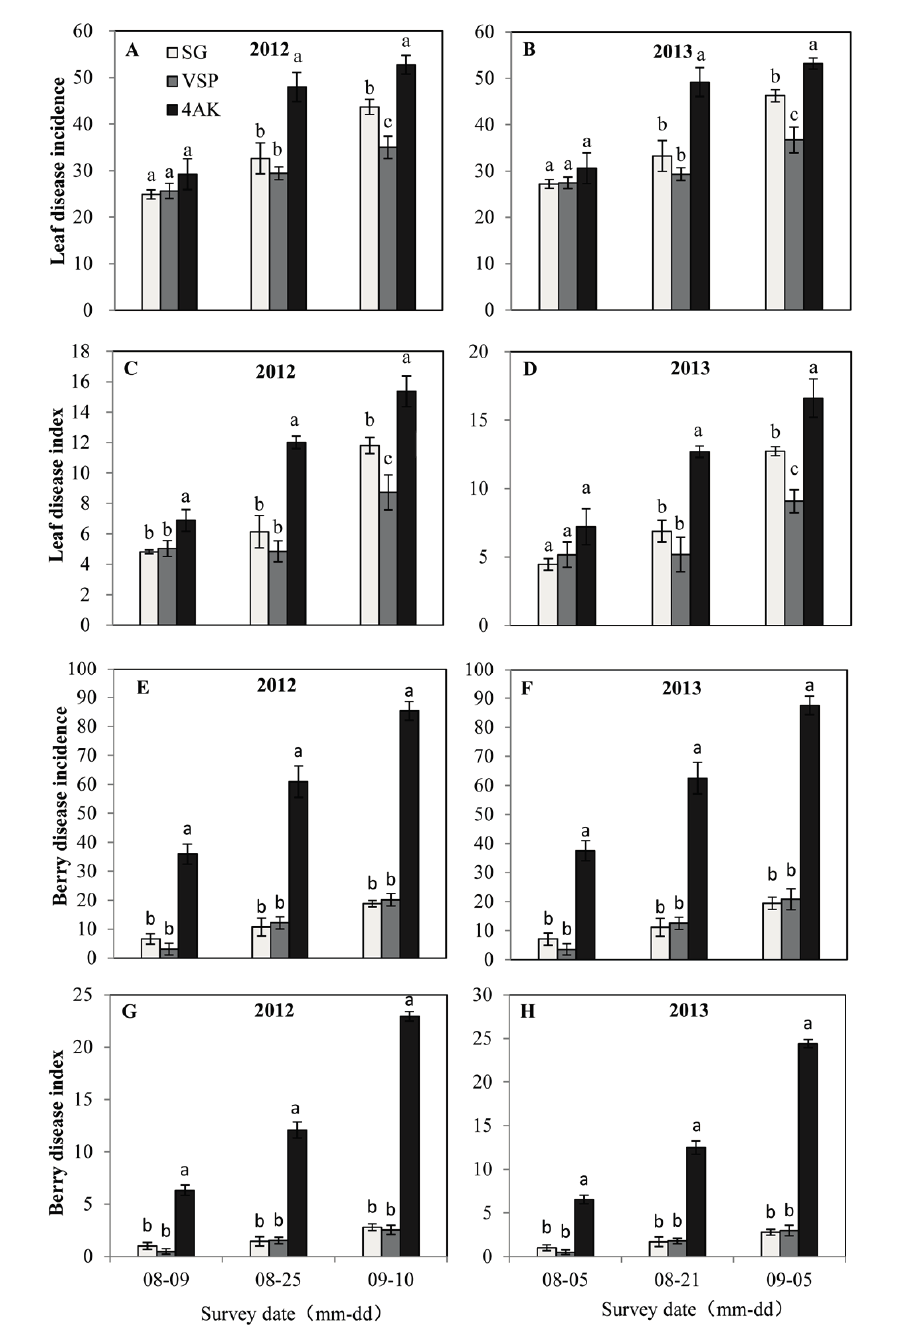
Figure 2. Disease of grape leaves and berries for the three training systems during ripening in 2012 and 2013 vintages. The bars indicate the mean of three replicates and their standard deviations. For the same year, different letters indicate significant differences between treatments calculated by Duncan’s test ( p < 0.05). ( A ) Leaf disease incidence in 2012; ( B ) Leaf disease incidence in 2013; ( C ) Leaf disease index in 2012; ( D ) Leaf disease index in 2013; ( E ) Berry disease incidence in 2012; ( F ) Berry disease incidence in 2013; ( G ) Berry disease index in 2012; ( H ) Berry disease index in